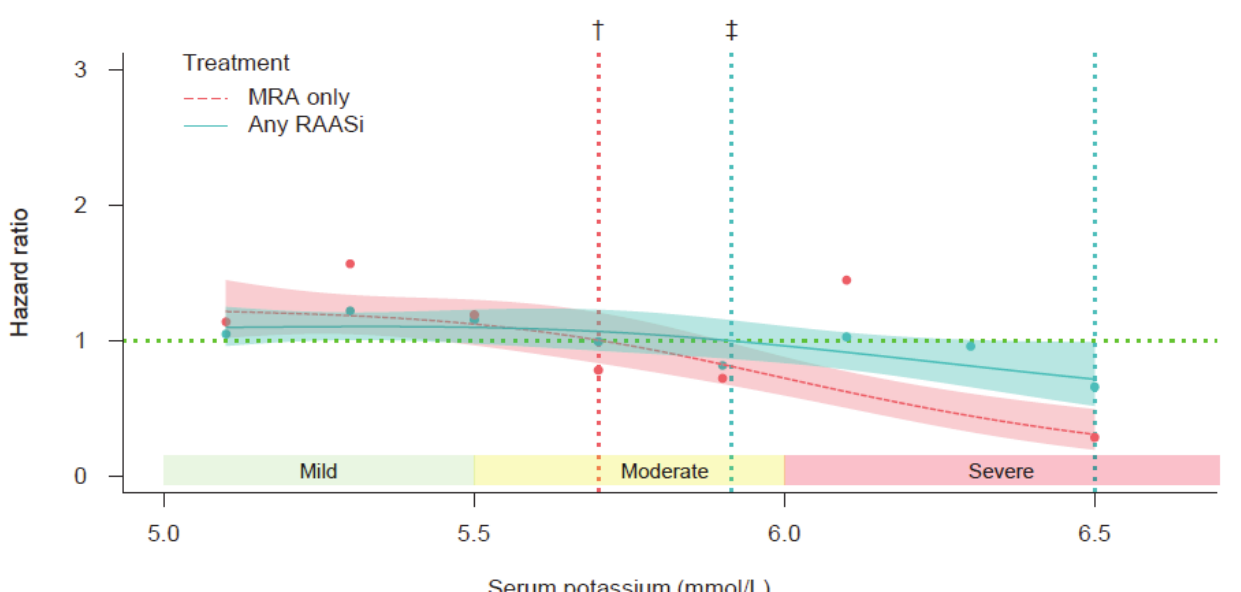
Figure 6. Cubic spline regression showing risk of in-hospital death as a function of serum potassium level. Data are plotted for propensity score-matched patients receiving any RAASi and for patients receiving an MRA only. The hazard ratio represents the risk of treatment cessation vs. no cessation. The dots in the figure show the point estimates of relative risks (i.e., hazard ratios of in-hospital death between patients with treatment cessation vs. no cessation) in each serum potassium value stratum. † Higher relative mortality risk of MRA cessation vs. no cessation up to serum potassium = 5.71 mmol/L. ‡ Higher relative mortality risk of RAASi cessation vs. no cessation up to serum potassium = 5.92 mmol/L. Abbreviations: MRA, mineralocorticoid receptor antagonist; RAASi, renin–angiotensin–aldosterone system inhibitor.